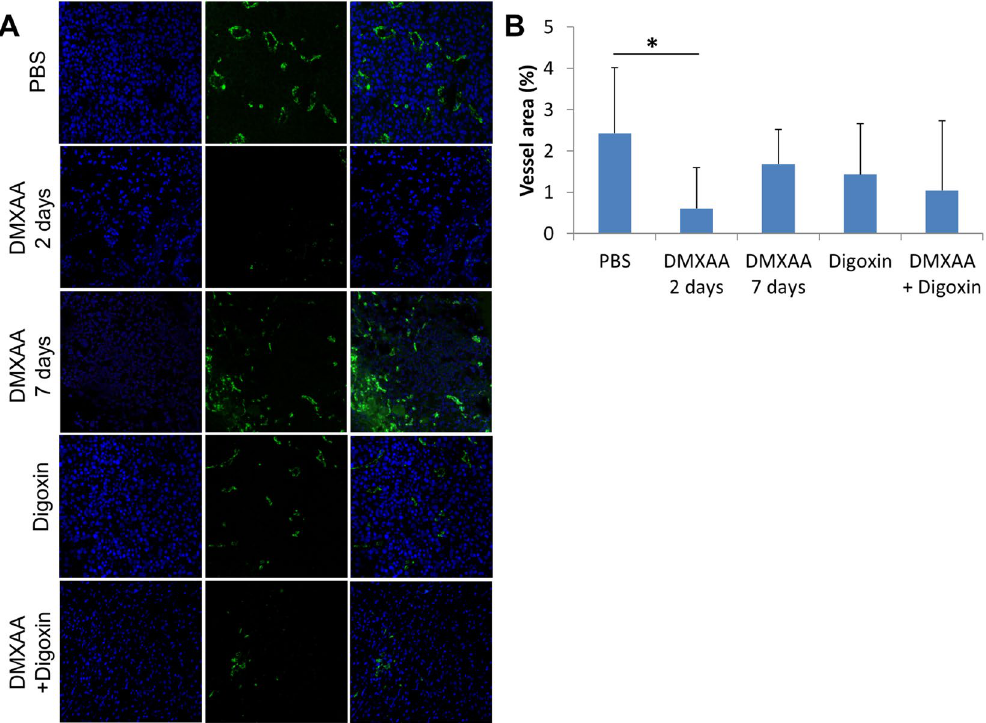
Figure 3. The area occupied by blood vessels in tumors after treatment with DMXAA and digoxin. DMXAA significantly decreases the area of blood vessels in the tumor ( * p < 0,05). After digoxin administration it is only slightly reduced. 7 days after DMXAA administration the vessels area increases while in the group treated with the combined therapy it is significantly smaller.